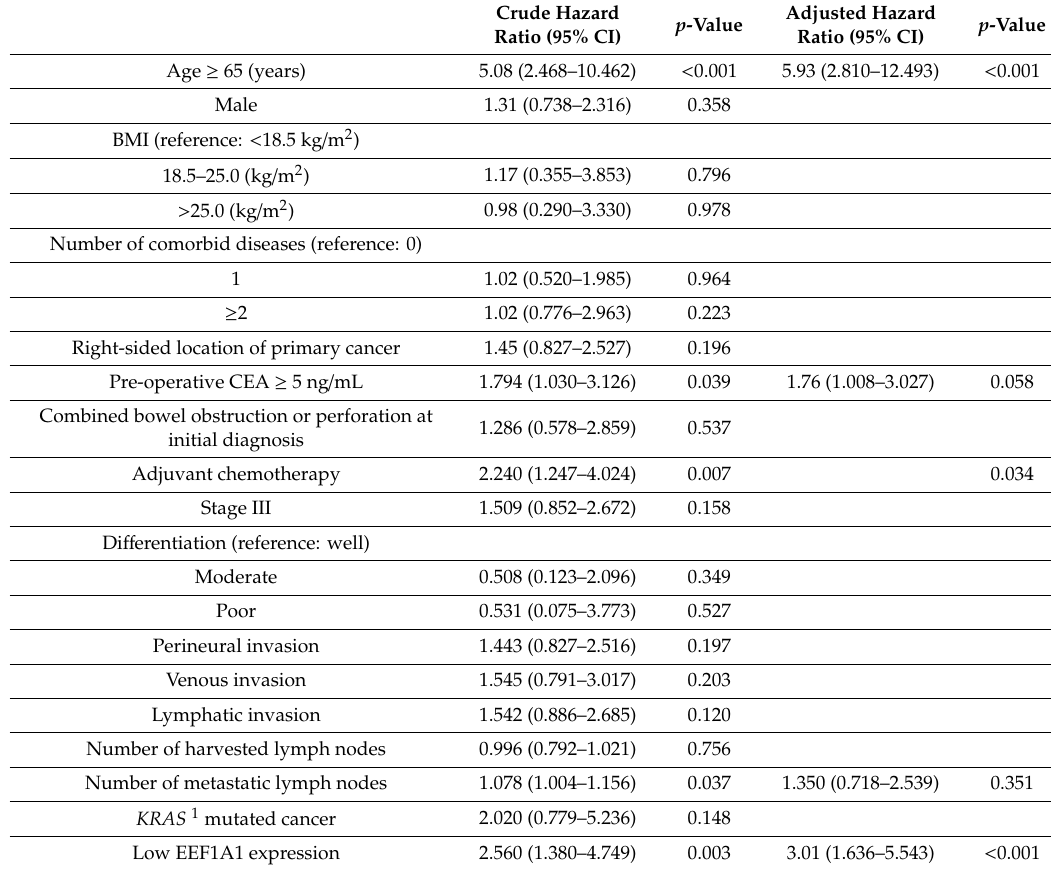
Table 2. Cox regression analysis of overall survival for 281 patients with curatively-resected colon cancer.